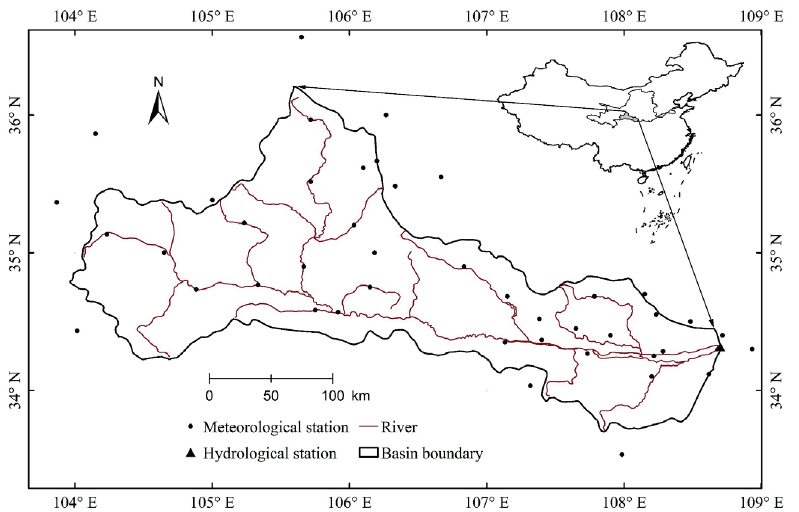
Fig. 1 Location of the Weihe River basin with meteorological and hydrological